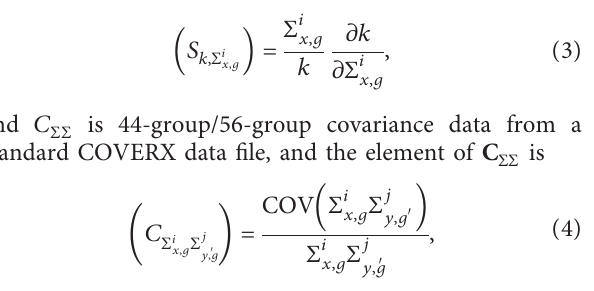
Table 1: Major SNF vectors of blanket fuel in B&BR.